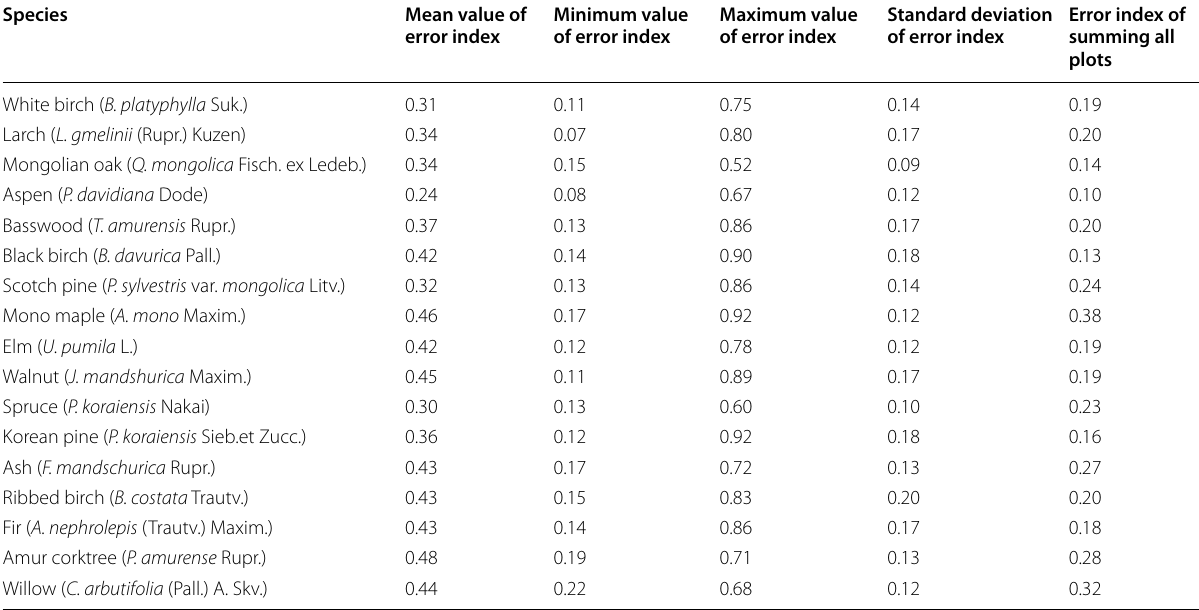
Error index of summing all plots is calculated by combining all plots as a whole